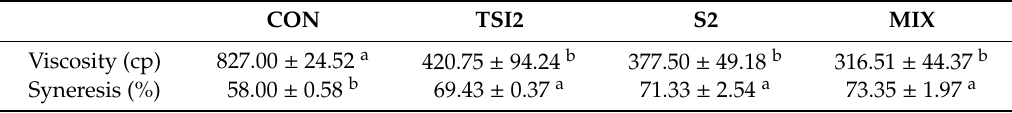
Table 5. Viscosity and syneresis of each starter after 24-h stabilization.